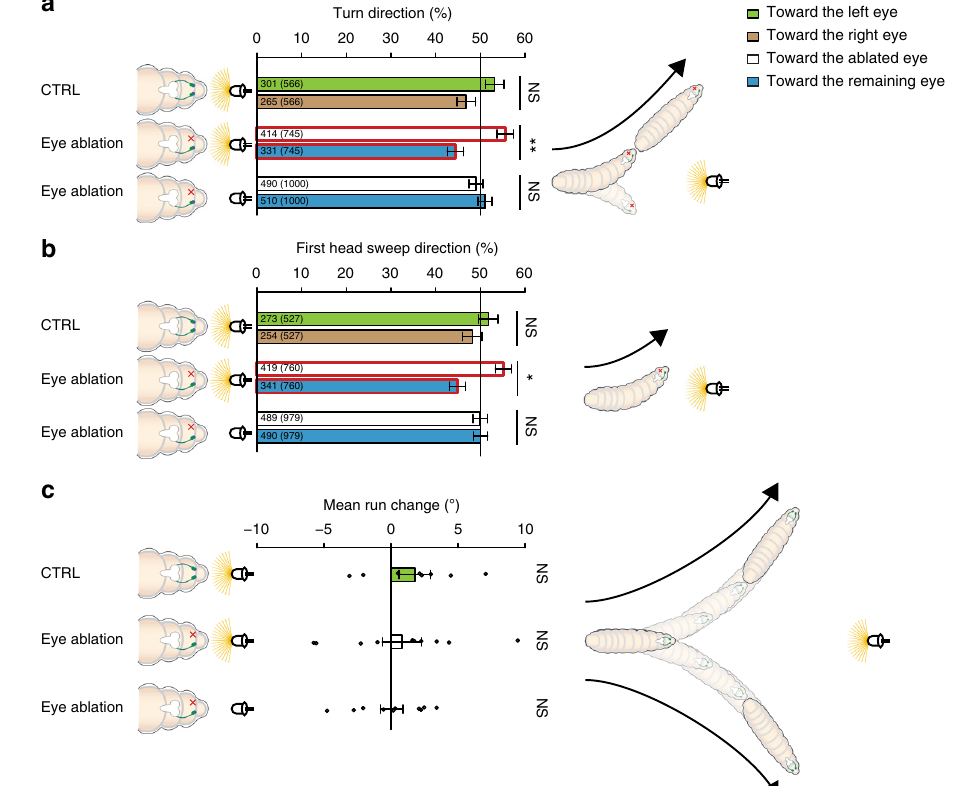
Fig. 2 Unilateral sensing larvae bias their fi rst head sweep direction and their turn direction toward the side of their blinded eye, when they are heading toward a light source. a Bilateral sensing control larvae do not bias their turn direction when they are facing a light source. Unilateral sensing animals bias their turn direction toward the blinded eye when heading toward a light source. These larvae do not bias their turn direction in absence of a light stimulus. Exact binomial test with n = numbers of turns: CTRL: n = 566, p = 0.2118; eye ablation light on: n = 745, p = 0.0079; eye ablation light off: n = 1000, p